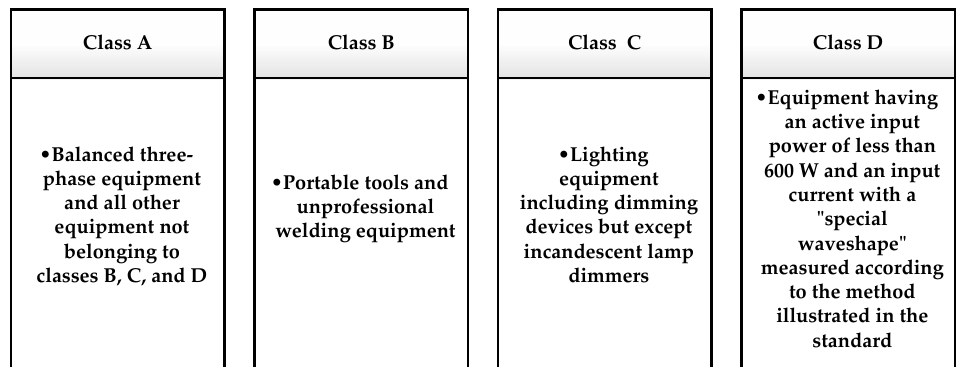
Figure 3. Classification of electrical equipment to limit harmonic pollution.